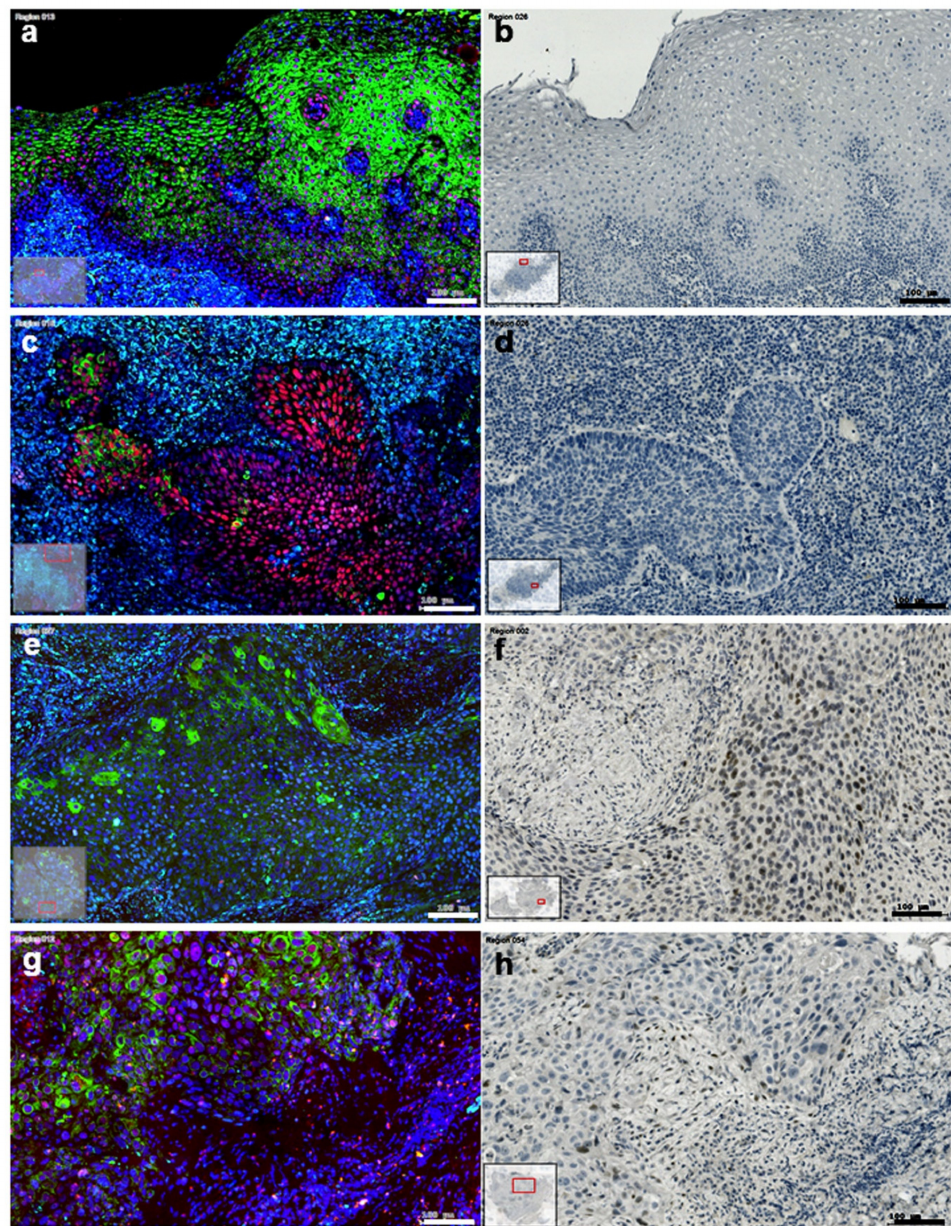
Figure 4. Comparison of immunohistochemical labeling of KLF4 (red), pan-cytokeratin (green) and vimentin (light blue) ( a , c , e , g ) with enzyme immunohistochemistry of Slug ( b , d , f , h ) in normal layered epithelium ( a , b ); in HPV + , p53 wild type HNSCC ( c , d ); in HNSCC with loss of p53 gene product ( e , f ) and in HNSCC with p53 gain of function mutation ( g , h ). The normal layered epithelium showed dispersed intensive green cytokeratin (CK) reaction, the nuclei of the CK + cells contained KLF4, the CK − stroma region contained vimentin-positive (VIM + ) cells ( a ). In this tissue no traces of Slug staining were detected ( b ). The HPV + p53 wild type HNSCC showed limited green cytokeratin (CK) reaction, the nuclei in cancer cell nests contained KLF4, also if they were CK − , the stroma region contained numerous vimentin-positive (VIM + ) cells ( c ). In this tissue no traces of Slug staining were detected ( d ). In the HNSCC with loss of p53 gene product diffuse CK reaction was detected at different levels in cells of the cancer cell nests, only few scattered nuclei in cancer cell nests contained red KLF4 reaction, the light blue reaction of VIM was spread in the stroma, but traces of VIM were also visible in the cancer cell nests ( e ). In this tissue intensive diffuse Slug reaction was detected ( f ). In HNSCC with p53 gain of function mutation diffuse CK reaction was detected at different levels in cells of the cancer cell nests, the majority of the nuclei in cancer cell nests contained red KLF4 reaction, and in this tissue section the vimentin reaction was scattered ( g ). Several cell nuclei at border areas of cancer cell nests were Slug + ( h